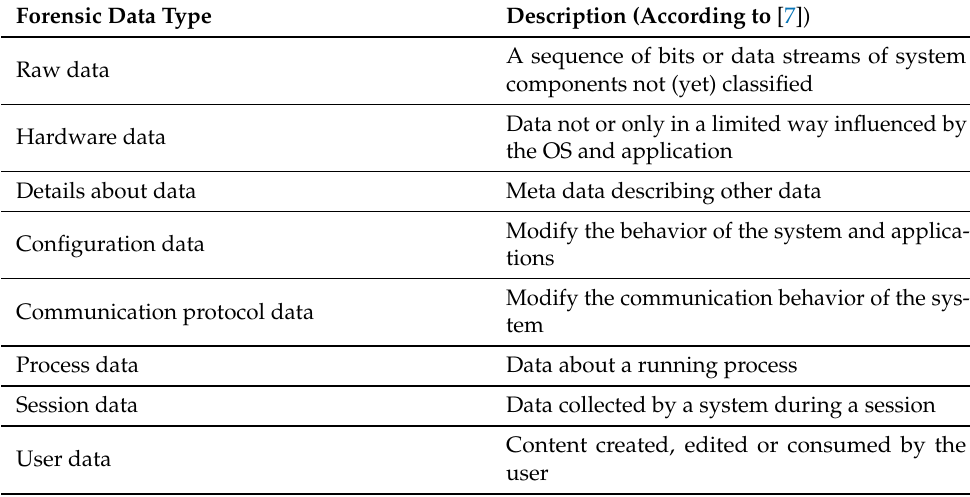
Table 2. Forensic data types defined in [7] (updated from [34]).